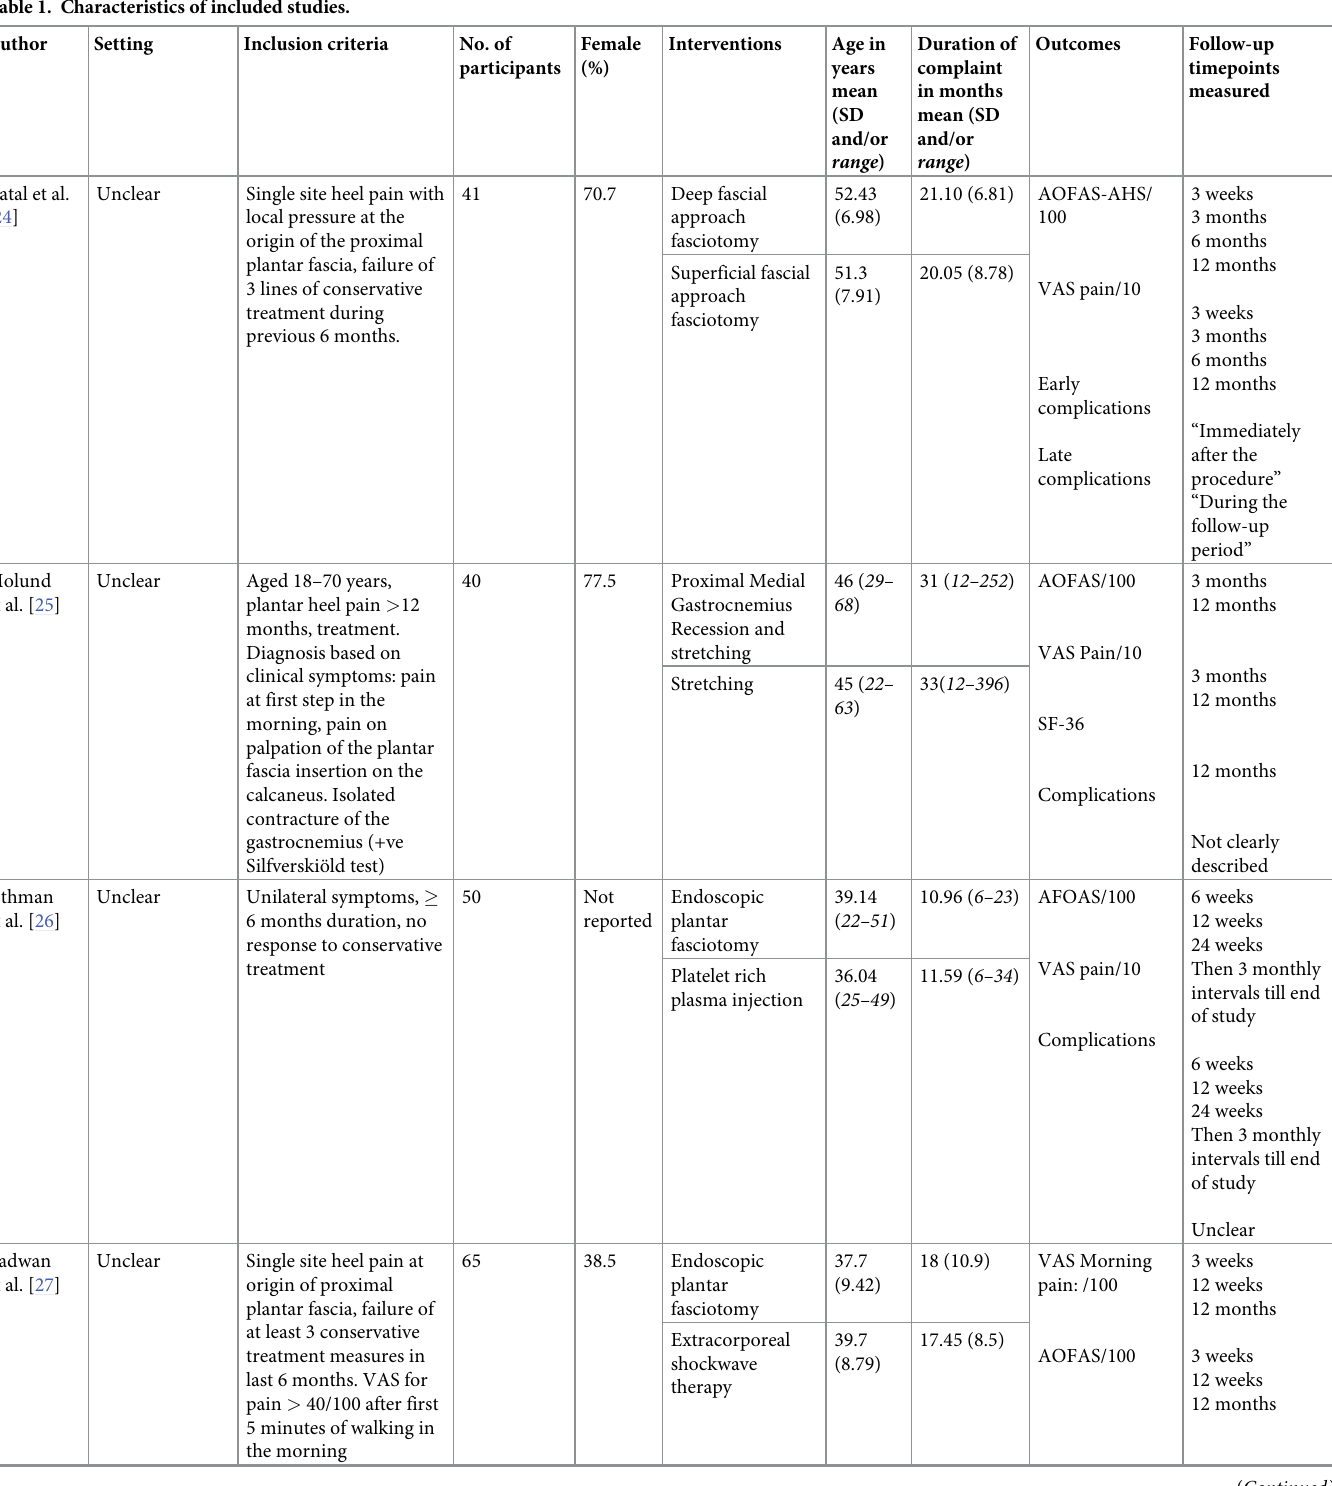
Table 1. Characteristics of included